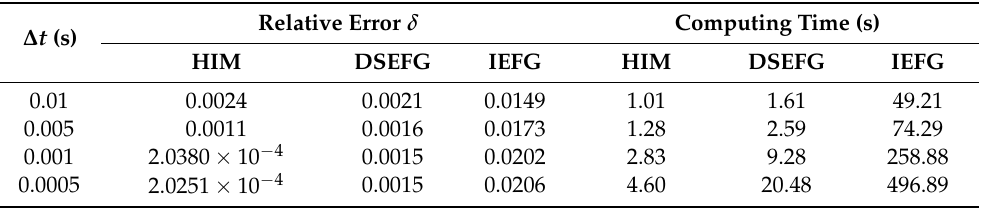
Table 2. Comparison of relative error and computing time when ∆ t is